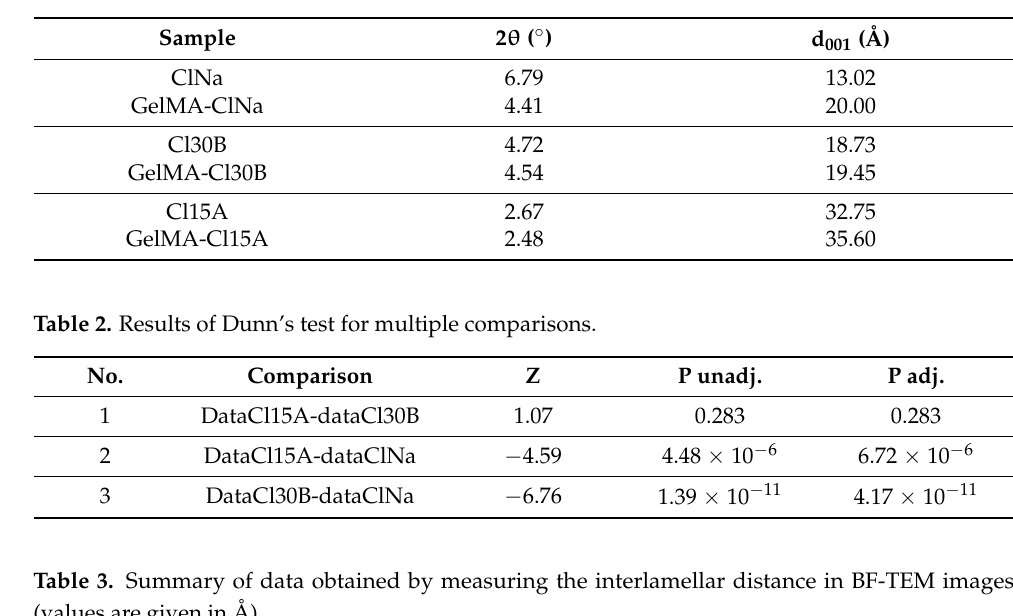
Table 1. The values of the clay characteristic diffraction peak d 001 at 2 θ .